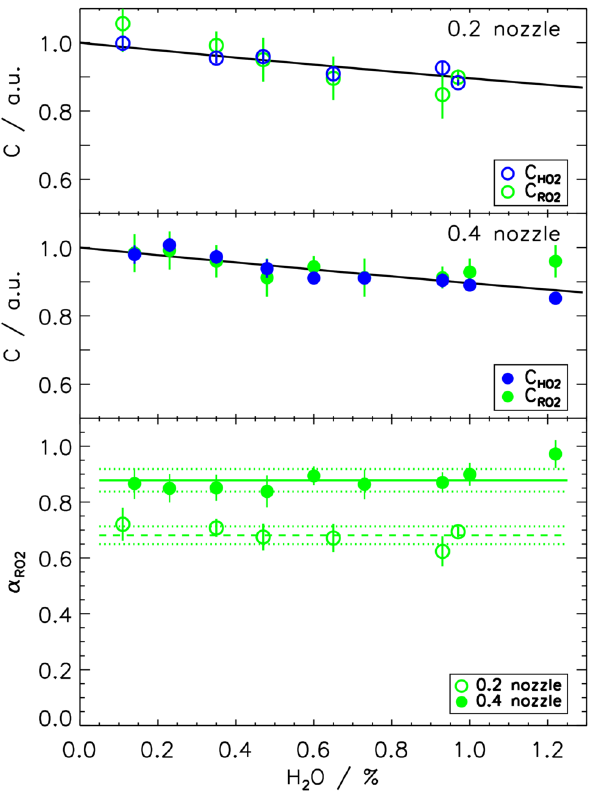
Fig. 7. Dependence of the interference from RO 2 radicals pro- duced by isoprene and OH on water vapor (lower panel) at high NO concentrations (0.2mm nozzle: 3 × 10 15 cm − 3 , 0.4mm noz- zle: 4 × 10 14 cm − 3 ). Experiments were carried out for two combi- nations of reaction times (orifice diameters) and NO concentrations. Symbols show individual measurement points and lines are average values (solid, dashed) and 1 σ standard deviations (dotted) of mea- surements. In the upper two panels the water vapor dependence of measured detection sensitivities for HO 2 , C HO , and RO 2 from 2 isoprene, C RO , (scaled to one dry conditions) is compared to cal- 2 culations that give the reduction of the instrument sensitivity due to fluorescence quenching by water vapor (black